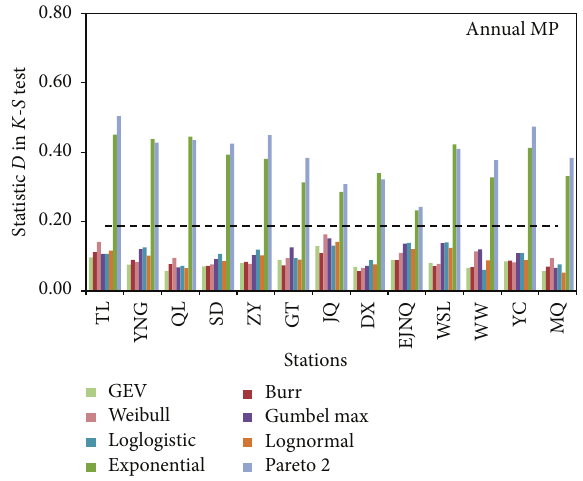
Figure 2: Values of statistic 𝐷 in K-S test for annual maximum precipitation of all stations by using different